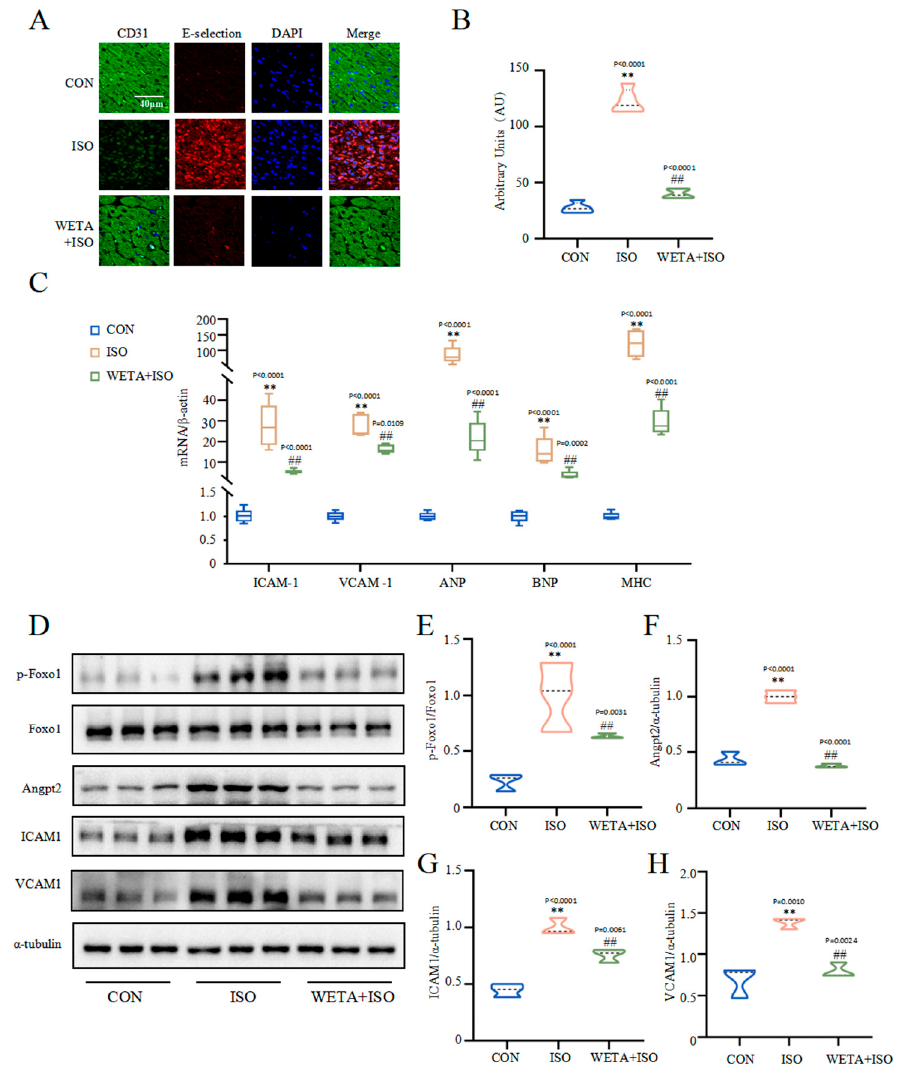
Figure 7. WETA attenuates cardiac myocardial damage. ( A ) Immunofluorescence staining images of E-selection (red), CD31 (green), and nuclei (blue) (scale bar = 40 µ m), ( B ) mean fluorescence intensity of E-selection, ( C ) expression of ANP, BNP, MHC, ICAM1, and VCAM1. ( D ) Western blot results of levels of p-Foxo1 ( E ), Angpt2 ( F ), ICAM1 ( G ) and VCAM1 ( H ). Values are mean ± SD (n = 6), ** p < 0.01 vs. CON group; ## p < 0.01 vs. ISO group, using one-way ANOVA.